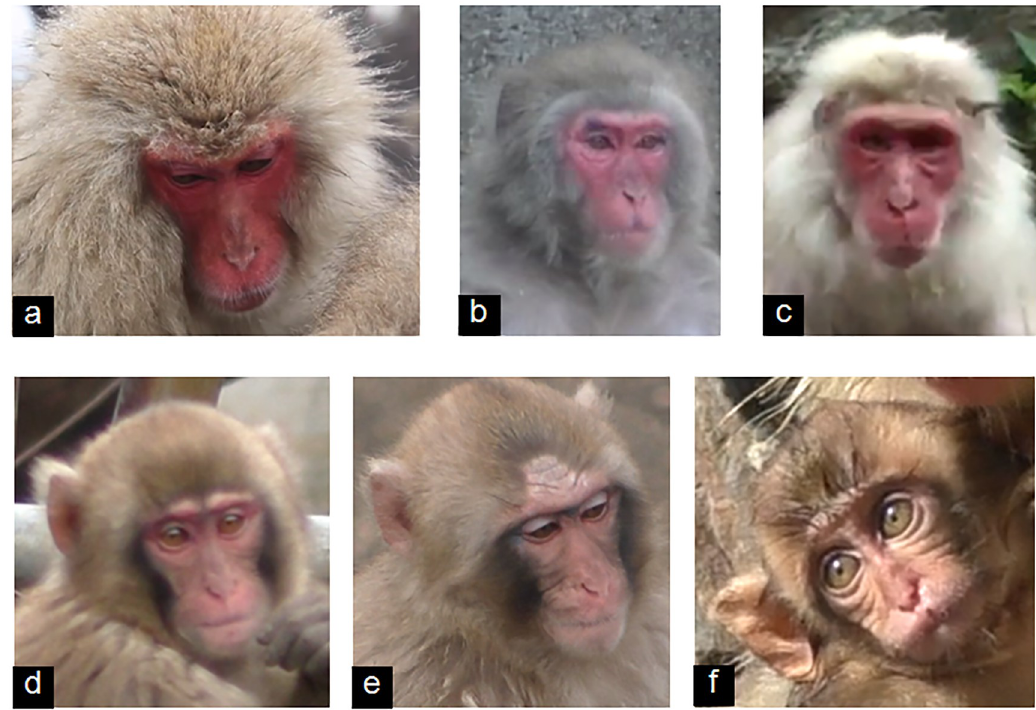
Fig 3. Browridge shape and size diversity in Japanese macaques adults (a–c) and infants (d–f).